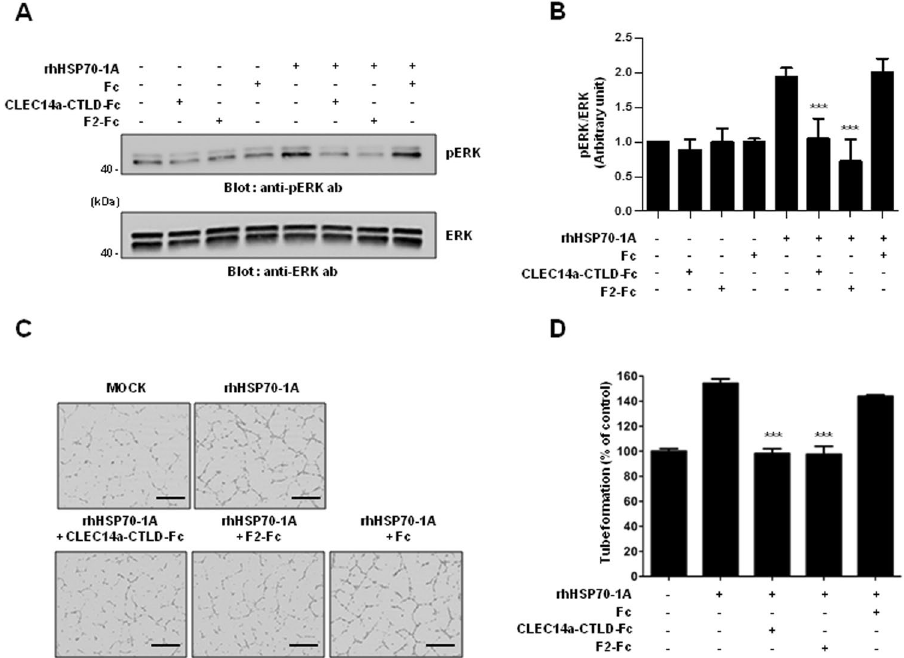
Figure 6. Effect of the HSP70-1A-interacting region of CLEC14a-CTLD on the HSP70-1A-induced ERK phosphorylation and tube formation of HUVECs. ( A ) A representative immunoblot showing the levels of total ERK (lower panel) and phosphorylated ERK (upper panel) in HUVECs incubated for 10 min in the absence (MOCK) or presence of 50 ng/ml rhHSP70-1A or 50 ng/ml rhHSP70-1A plus 20 μ g/ml CLEC14a-CTLD-Fc, F2-Fc, or Fc. ( B ) Bar graphs show the mean band densities of pERK normalized with respect to total ERK (pERK/ERK ratio). ( C ) Representative light microscopic images of tubes formed by HUVECs incubated for 6 h in the absence (MOCK) or presence of 50 ng/ml rhHSP70-1A or 50 ng/ml rhHSP70-1A plus 20 μ g/ml CLEC14a-CTLD-Fc, F2-Fc, or Fc (scale bar = 500 µ m). ( D ) Quantitation of the total number of tube branches, expressed as a percent of control (MOCK) tube formation. All data are presented as the mean ± SEM of quadruplicate measurements from two independent experiments; *** P <